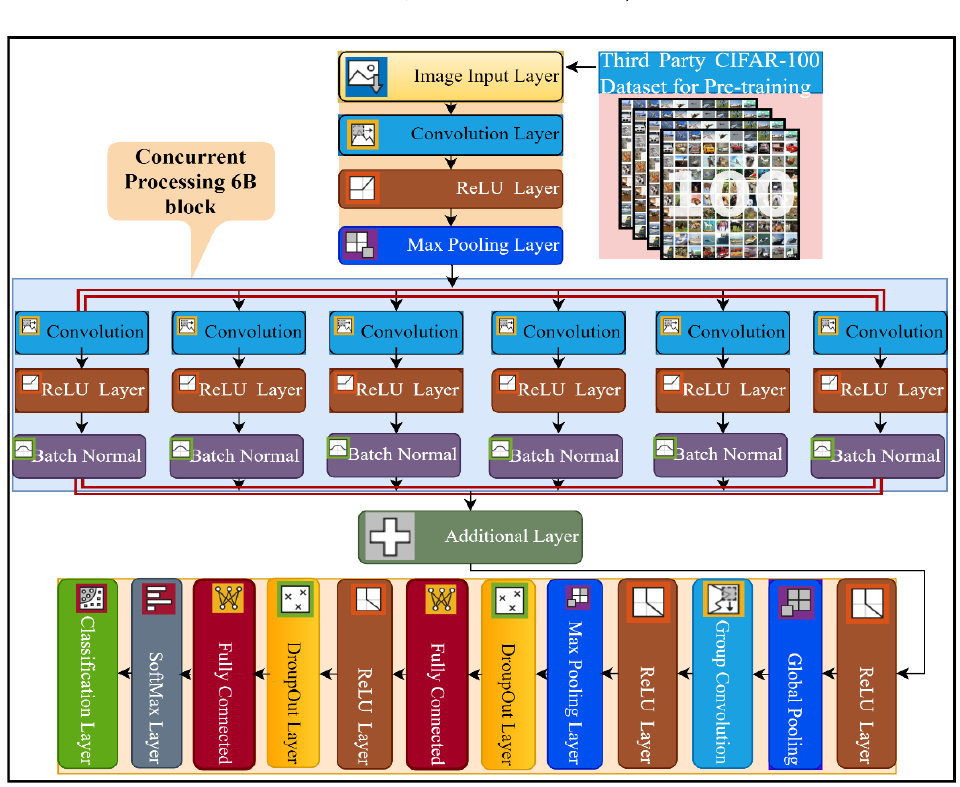
Figure 2. The pre-training and layer architecture diagram of the proposed 6B-Net deep CNN